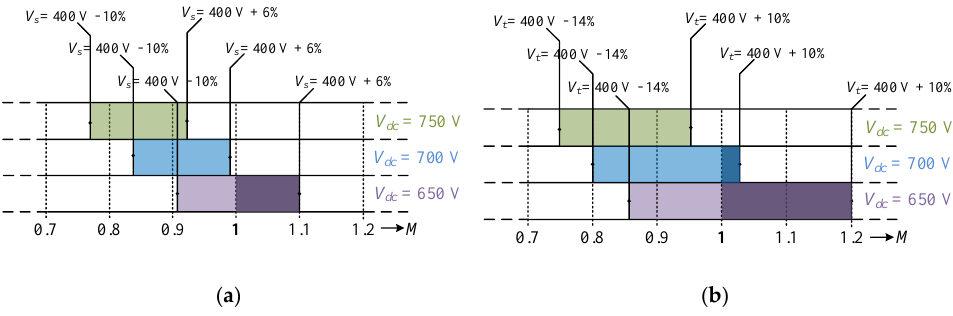
Figure 7. The variation range of modulation index, M as a function of chosen DC link voltage, V dc and operating voltage (acceptable low voltage variation ranges for 230/400 V, 50 Hz systems are as specified in IEC 60038 2002-07 Standard Voltages): ( a ) for the supply side voltage range of V s = 400 V +6% to −10%; and ( b ) for the utilization voltage range of V t = 400 V +10% to −14%.